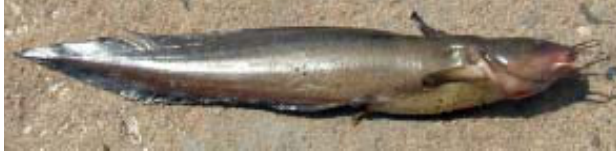
Image 16. Gray Eel Catfish Plotosus